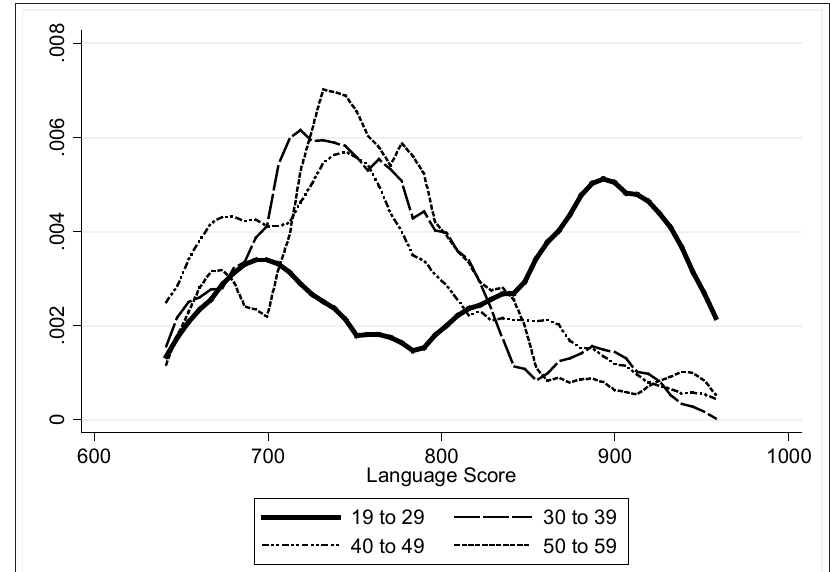
Figure 2: Teacher language score by age group (Source: SACMEQIII 2007) Similar analysis was conducted for Botswana, Kenya and Zimbabwe. The differences in the performance of teachers of different ages are not as marked as they are in South Africa. It therefore seems that this is a phenomenon particular to South Africa.